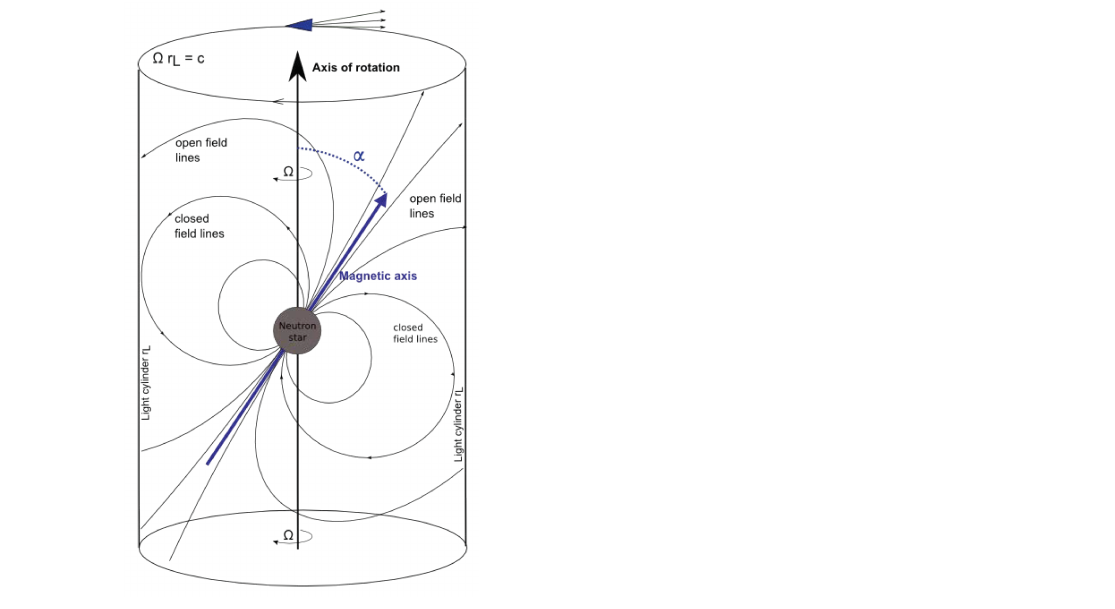
Figure 1. Sketch of the magnetospheric pulsar model from [22]. The centrifugally accelerated co-rotating particles in the nearby zone of the LC area emit in a relatively narrow cone along the tangential